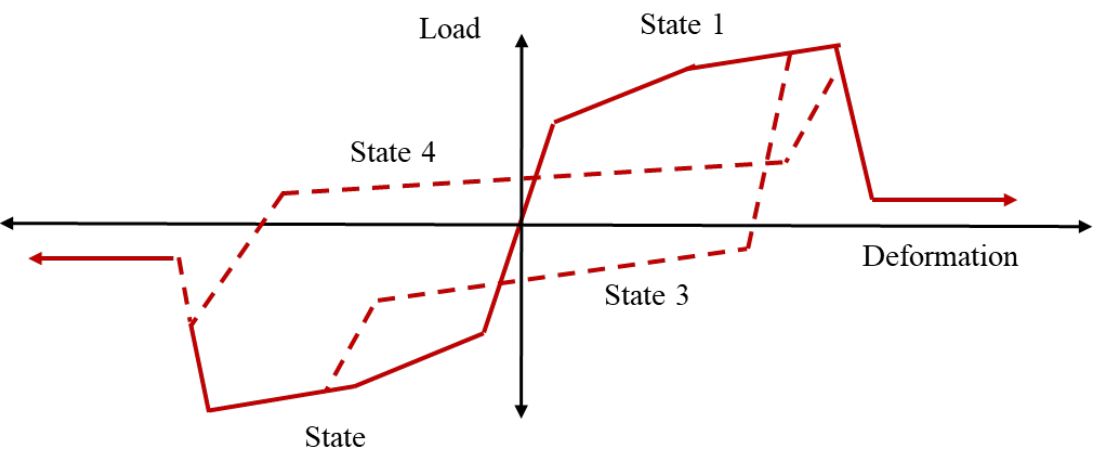
Figure 10. Strength and stiffness deterioration in subsequent cycles, reproduced from literature [47].